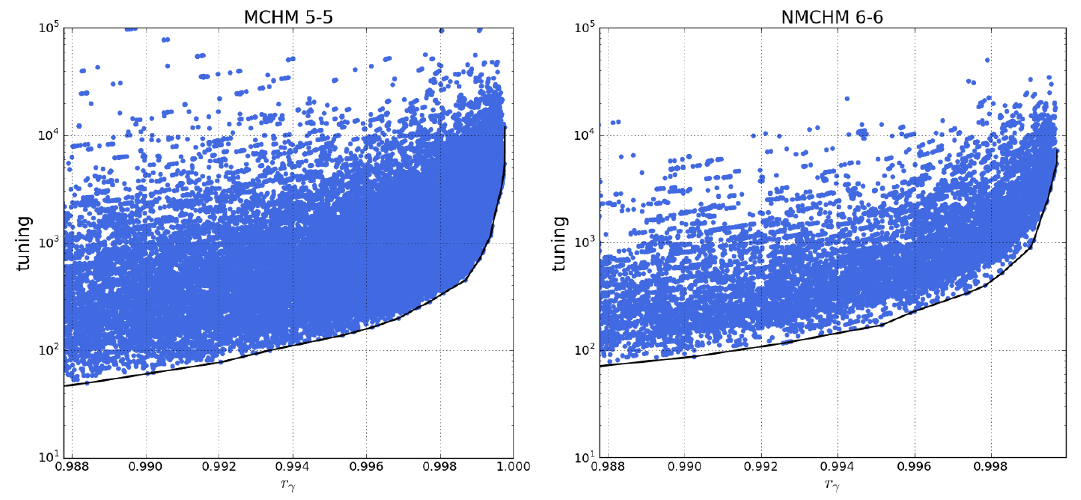
Figure 8. Comparison of higher-order tuning in the Higgs-photon (loop) coupling deviation, between the minimal and next-to-minimal models. Future ILC bounds are below the cut-o(cid:11) f > 800 GeV.